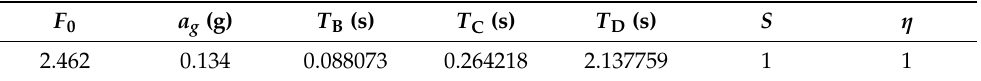
Table 3. Parameters of design spectrum of the studied cavern for horizontal